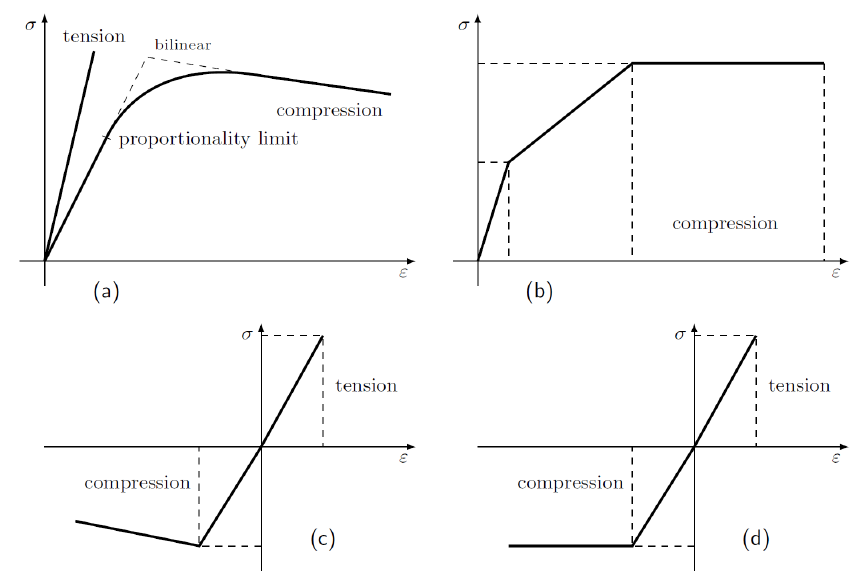
Figure 2. Stress-strain relationship for wood under tension and compression parallel to grain. ( a ) linearity in tension and nonlinearity in compression, e.g., at [46], ( b ) multilinearity in compression, e.g., at [30,37], ( c ) compression parallel to grain as suggested by [104], ( d ) elastic and perfectly plastic in compression, e.g., at